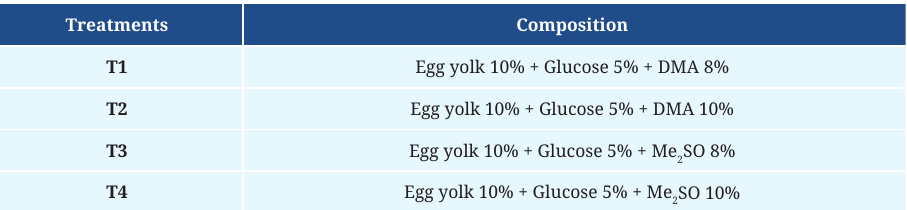
FIGURE 1 | Adult male specimen of Pseudoplatystoma corruscans , belonging to the Hydrobiology Station of the Jupiá Hydroelectric Plant. TABLE 1 | Extenders (Treatments) used in Pseudoplatystoma corruscans sperm